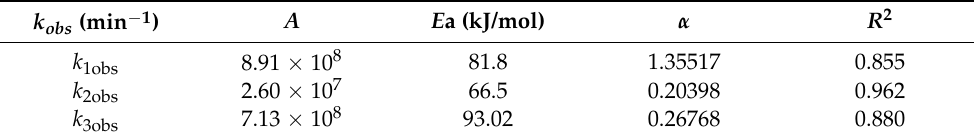
Table 5. Calculated kinetic factors for xylose dehydration to furfural ( k 1obs ), xylose condensation to humin ( k 2obs ), and furfural decomposition to humin ( k 3obs ) by multiple linear regression for p TSA-CrCl 3 · 6H 2 O catalyzed dehydration of xylose in DMSO solvent